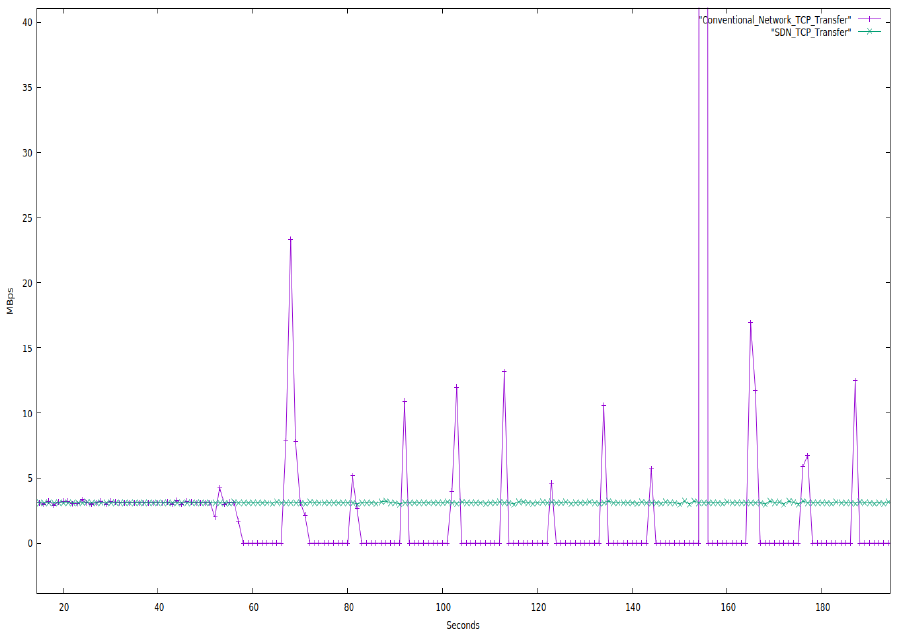
Figure 7. Transfer Rate/Throughput of TCP SDN vs. Traditional Network.